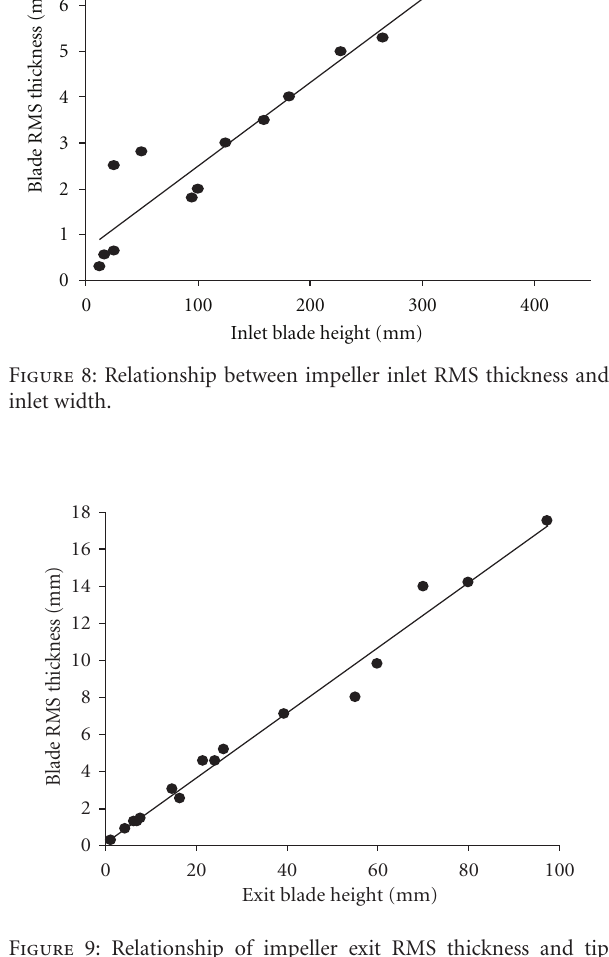
Figure 9: Relationship of impeller exit RMS thickness and tip